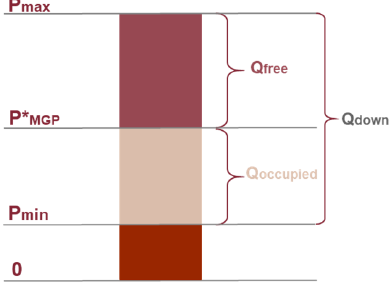
Figure 6. The illustrative example of the three different types of offers in the auction.